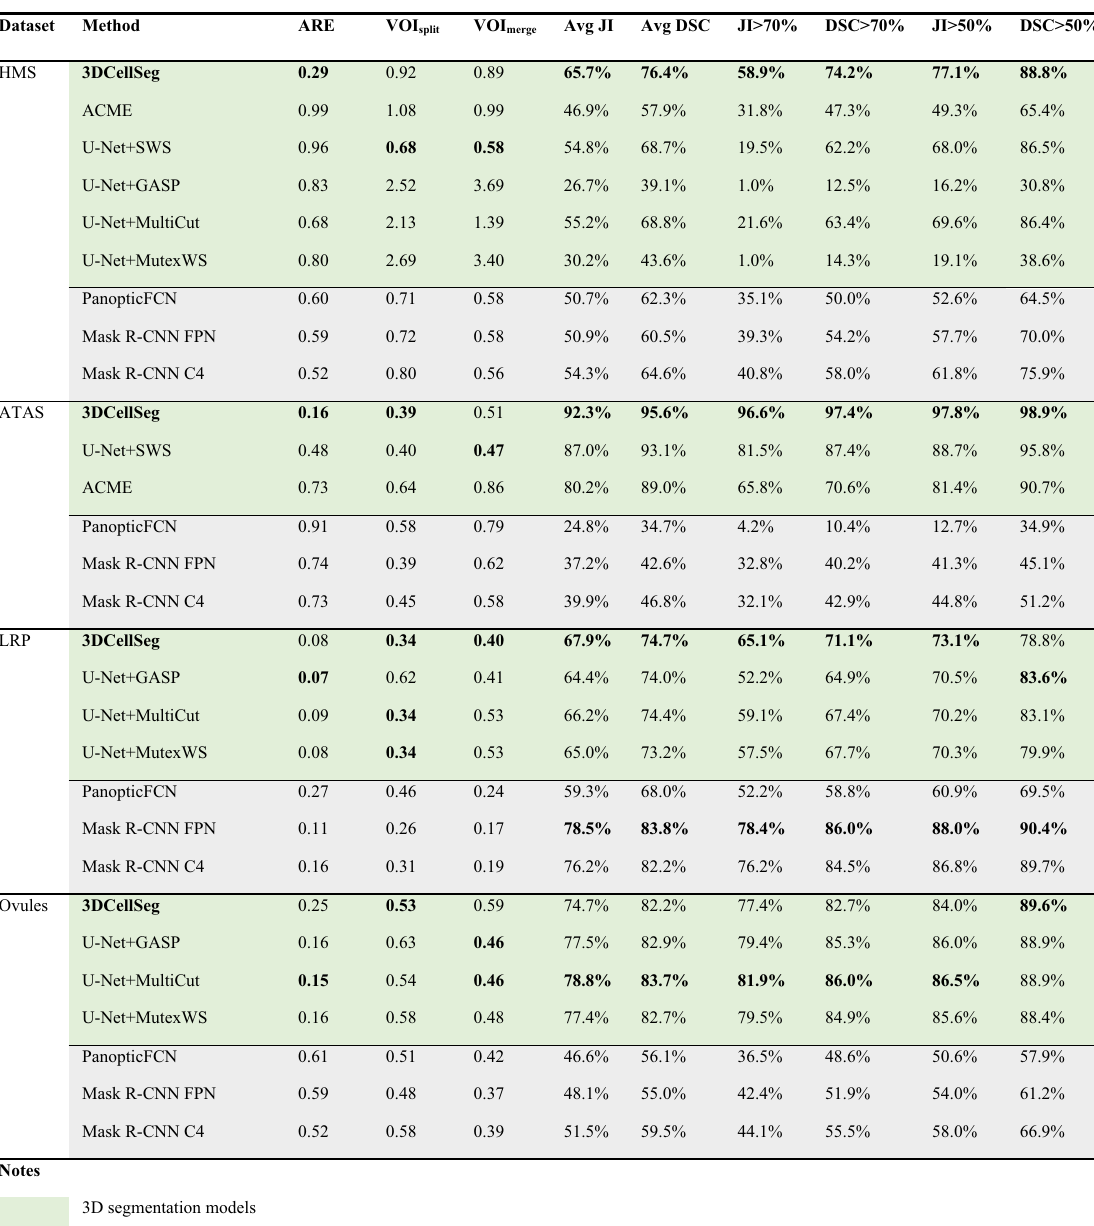
Table 3. Comparison of model performance on the HMS, ATAS, LRP, and Ovules datasets. [Note: For the HMS dataset, U-Net + SWS, U-Net + GASP, U-Net + MultiCut, and U-Net + MutexWS were retrained on default hyperparameters, and compared with our 3DCellSeg. For the ATAS dataset, U-Net + SWS, which was originally developed, trained and fine-tuned on the ATAS dataset, was compared with 3DCellSeg. For the LRP and Ovules datasets, U-Net + GASP, U-Net + MultiCut, and U-Net + MutexWS , which were originally built, trained and fine-tuned on LRP and Ovules, were compared with 3DCellSeg. Object-detection based instance segmentation methods (PanopticFCN, Mask R-CNN FPN, and Mask R-CNN C4) trained on 2D slices of the HMS, ATAS, LRP, and Ovules datasets were also taken as baselines for model comparison. ARE, VOI split , VOI merge , JI-related, and DSC-related metrics were calculated on 3D space for 3DCellSeg, ACME, U-Net + SWS, U-Net + GASP, U-Net + MultiCut, and U-Net + MutexWS and were calculated on 2D slices for PanopticFCN, Mask R-CNN FPN, and Mask R-CNN